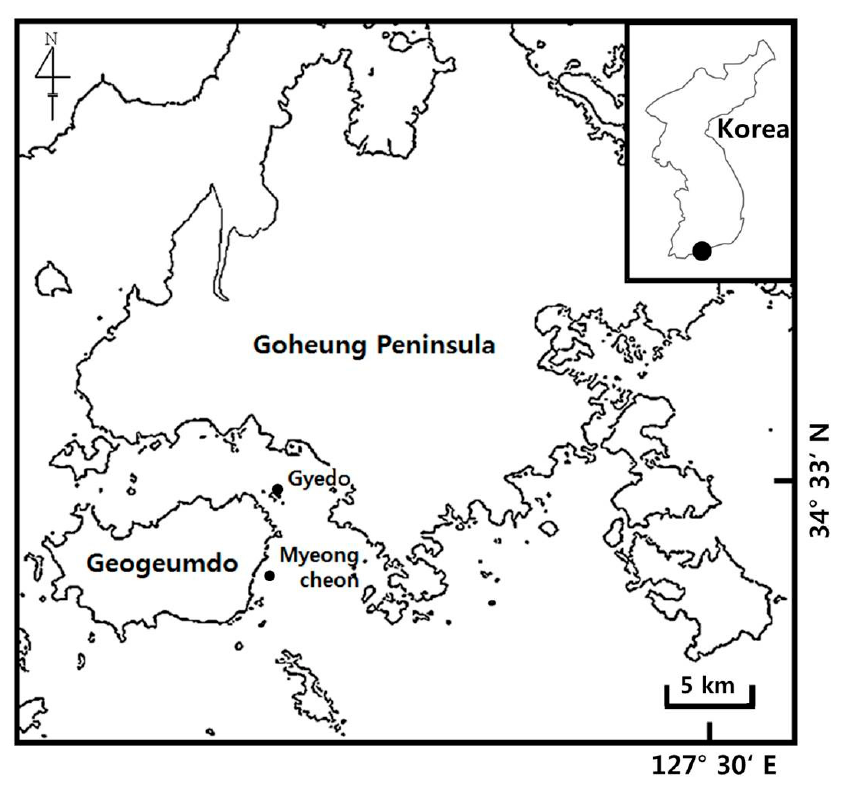
Figure 1. Map showing cultivation sites at Gyedo and Myeongcheon. Measurements of seawater temperature (Temp), salinity (Sal), total nitrogen (TN), total phosphorus (TP), and suspended particulate matter (SPM) at Myeongcheon (M) and Gyedo (G) aquafarms between January and May